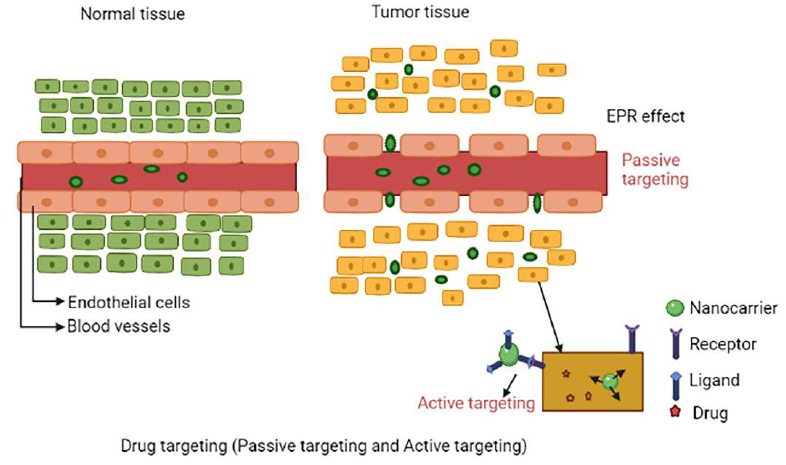
Figure 1. Schematic representation of drug targeting via passive targeting (EPR effect) mode and active targeting mode.